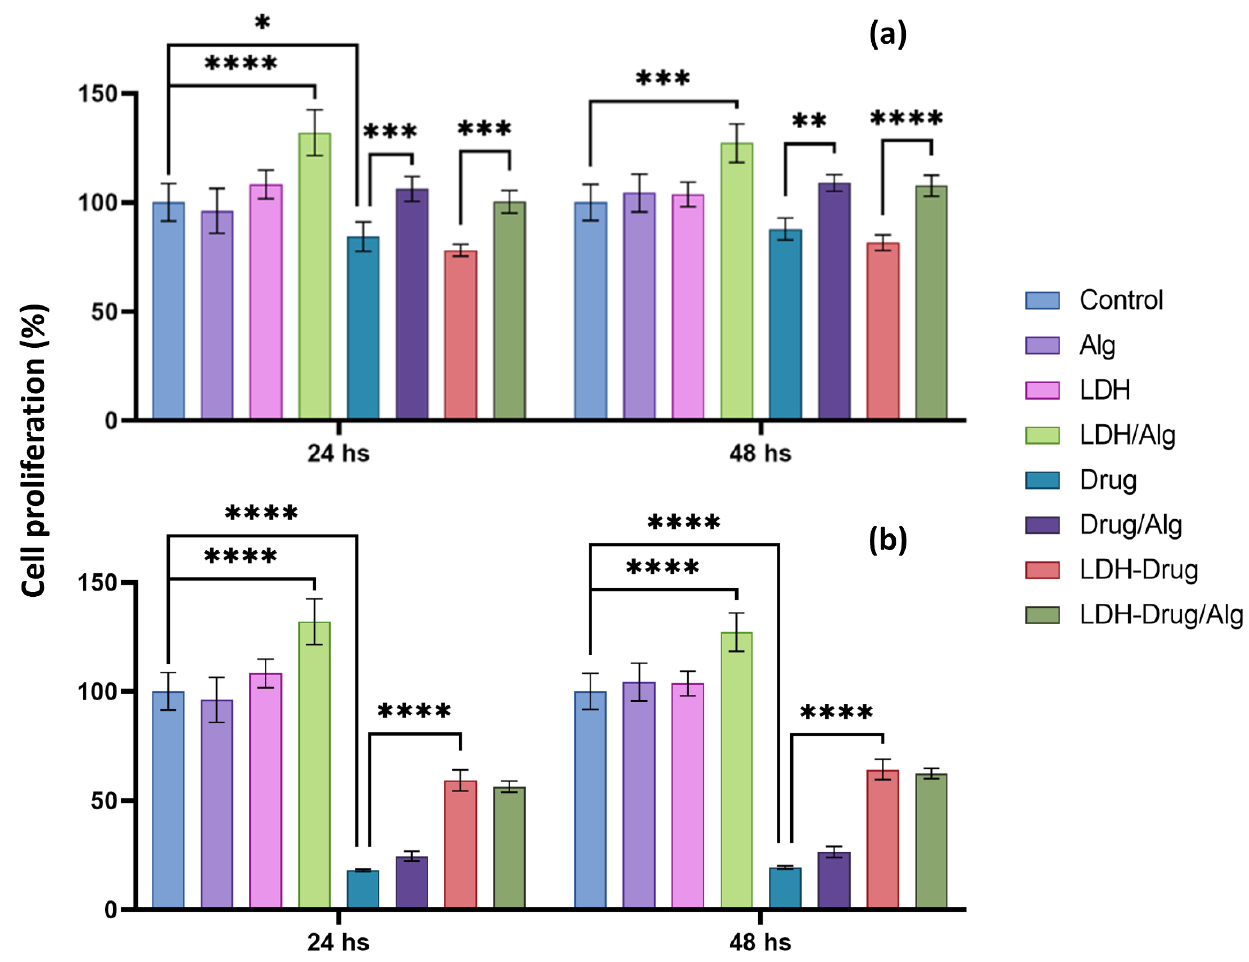
Figure 5. Anti-cytotoxic effect of 5 g L − 1 LDH-Drug/Alg in MC3T3-E1 cell cultures. Proliferation of MC3T3-E1 cells cultured in CM (control), Alg, LDH, LDH/Alg, Drug (Ibu ( a ) and Nap ( b )), Drug/Alg, LDH-Drug, LDH-Drug/Alg. Fluorescence of alamarBlue was measured at 24 and 48 h of and expressed as a percentage of control proliferation at that given time. Asterisks indicate significant differences between the indicated groups (****, p < 0.0001, ***, p < 0.001, **, p < 0.01 and *, p < 0.05).